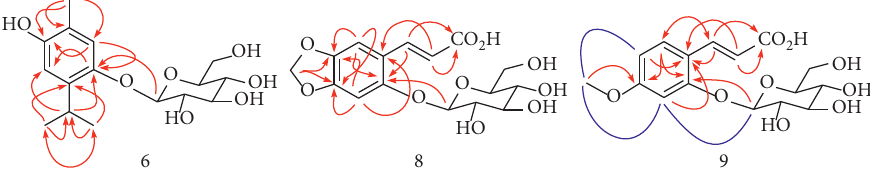
Figure 2: HMBC ( ⟶ ) and NOESY (—) correlations of compounds 6 , 8 , and 9